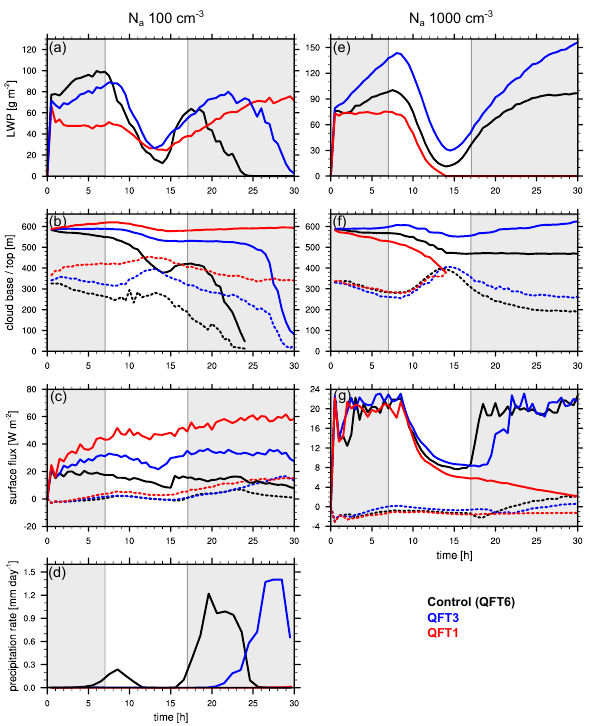
Fig. 9. The same as Fig. 6, except for Control (black), DIV3 (blue) and DIV8 (red) case.